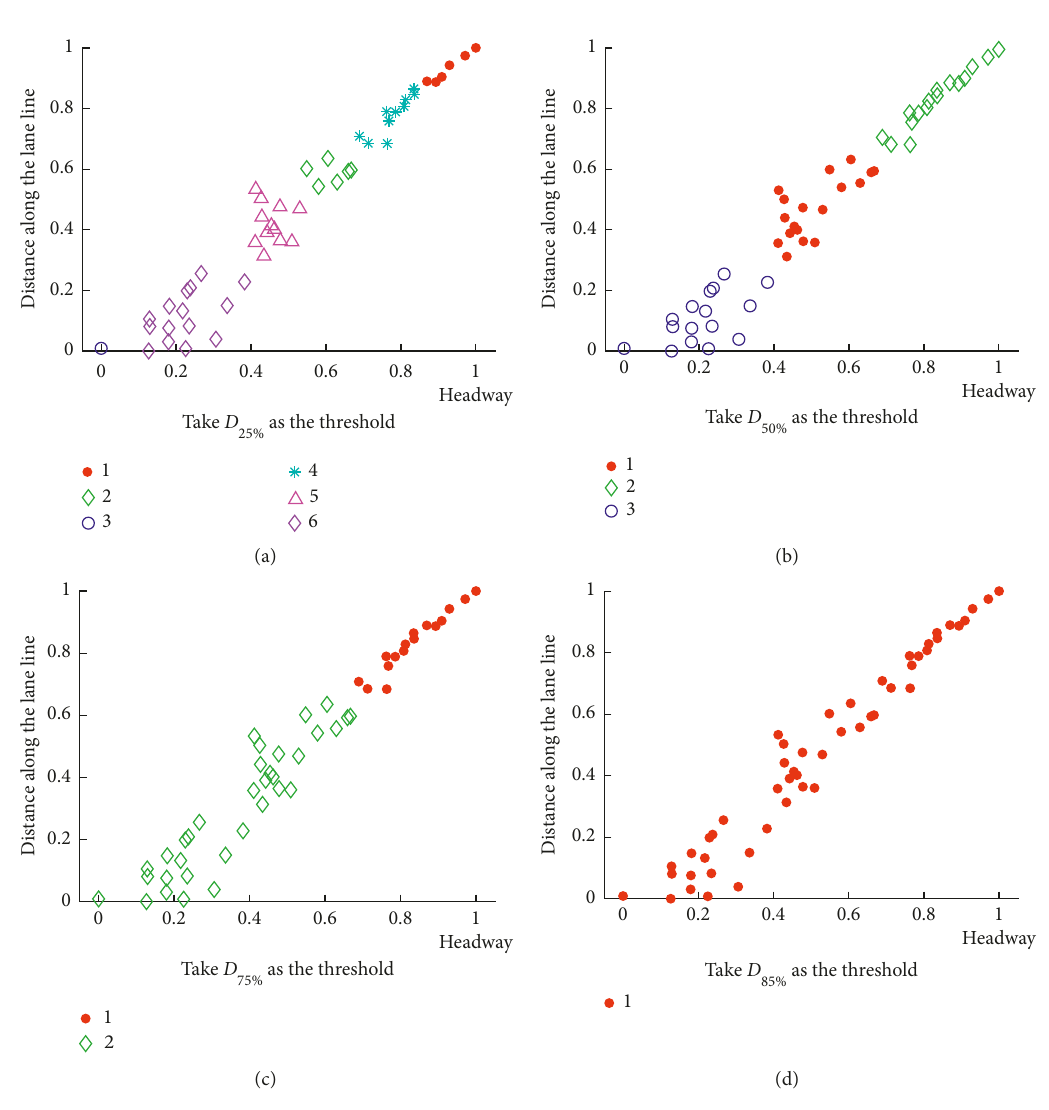
Figure 5: Division results for different